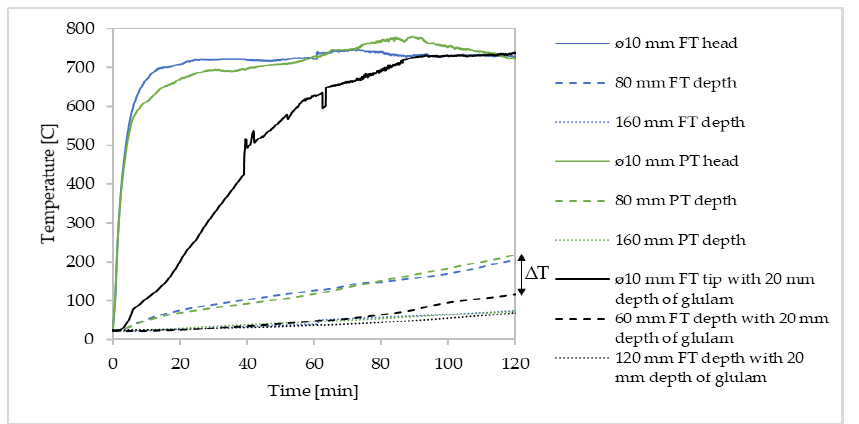
Figure 7. Time–temperature curves of Ø 10 × 160 mm screws with the exposed heads and the exposed tips.